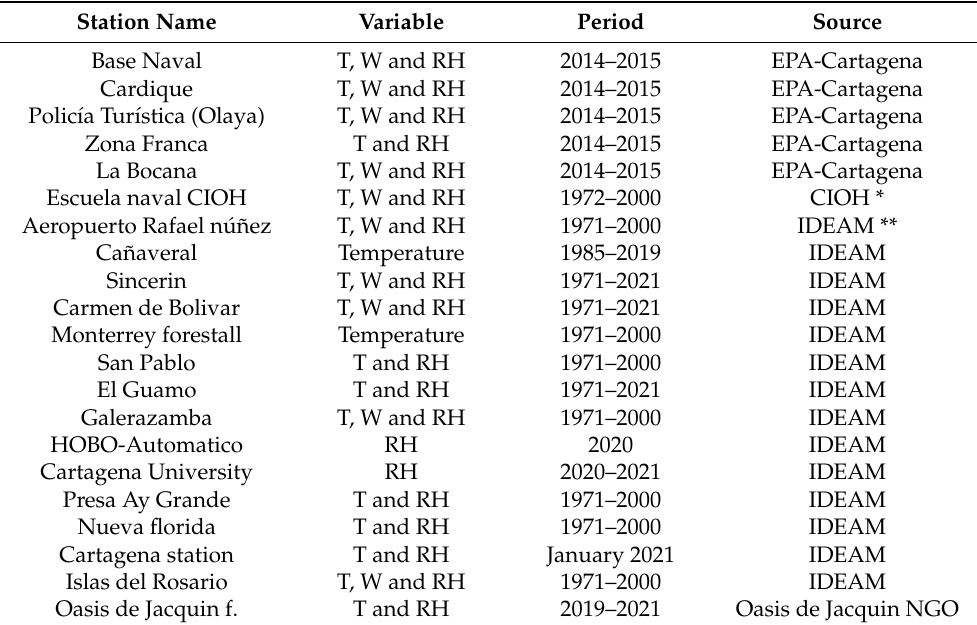
Figure 2. Location of the stations used in this study. Table 1. Meteorological stations used in the present study .